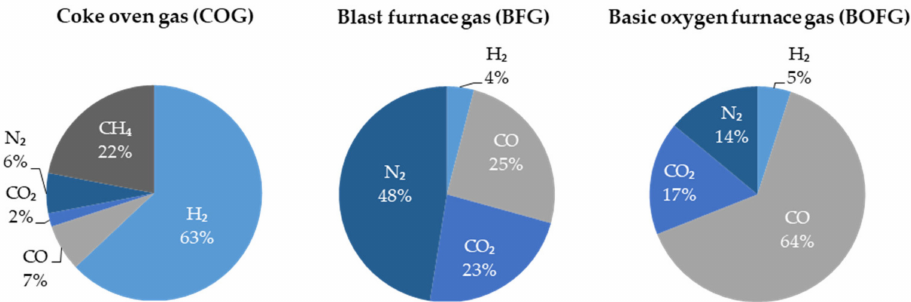
Figure 1. Typical gas composition in vol. % of steel-mill